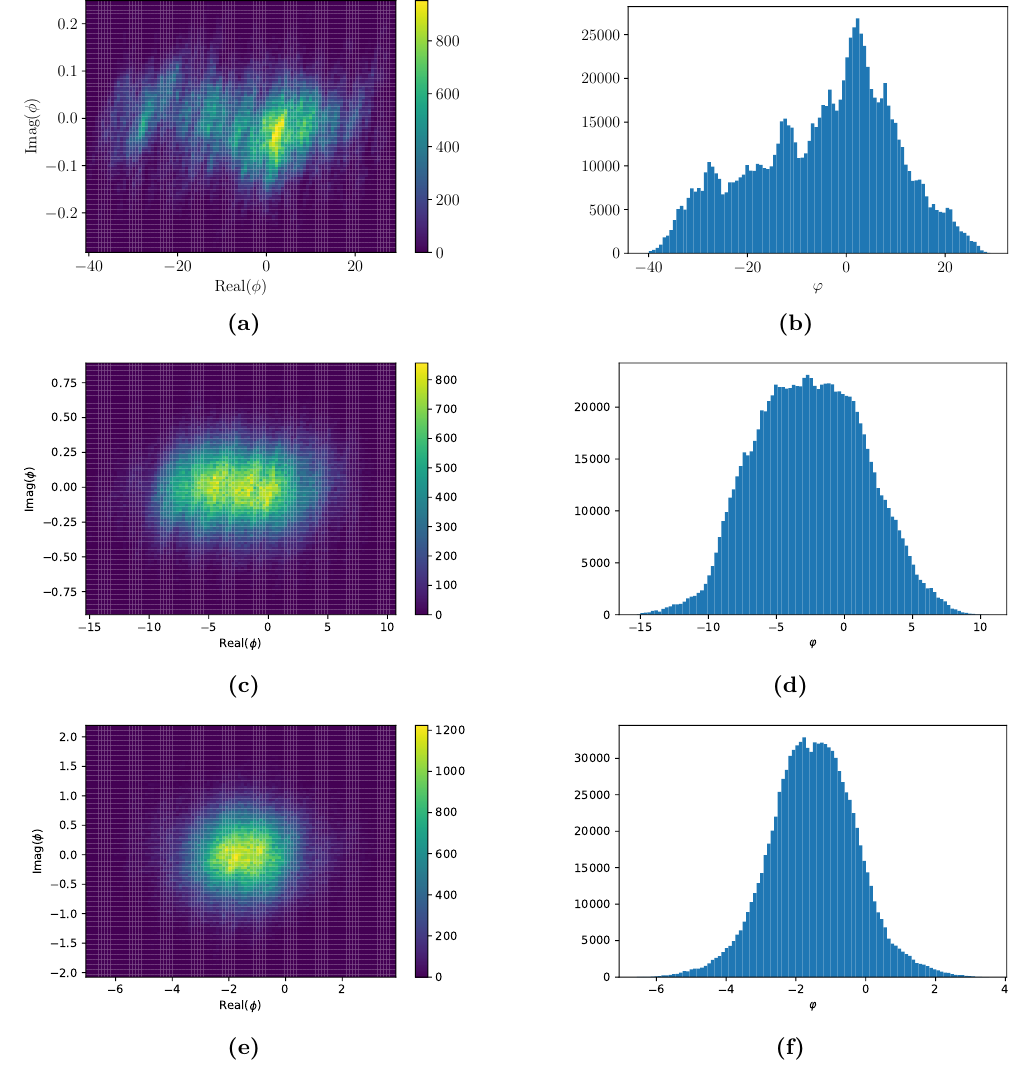
Figure 8. Complex domain of a single field variable during the MC sampling of a multivariable system (left) and the corresponding domain in terms of the un-flowed real variable (right). Top to bottom, τ max = 0 . 01 , 0 . 1 , 1